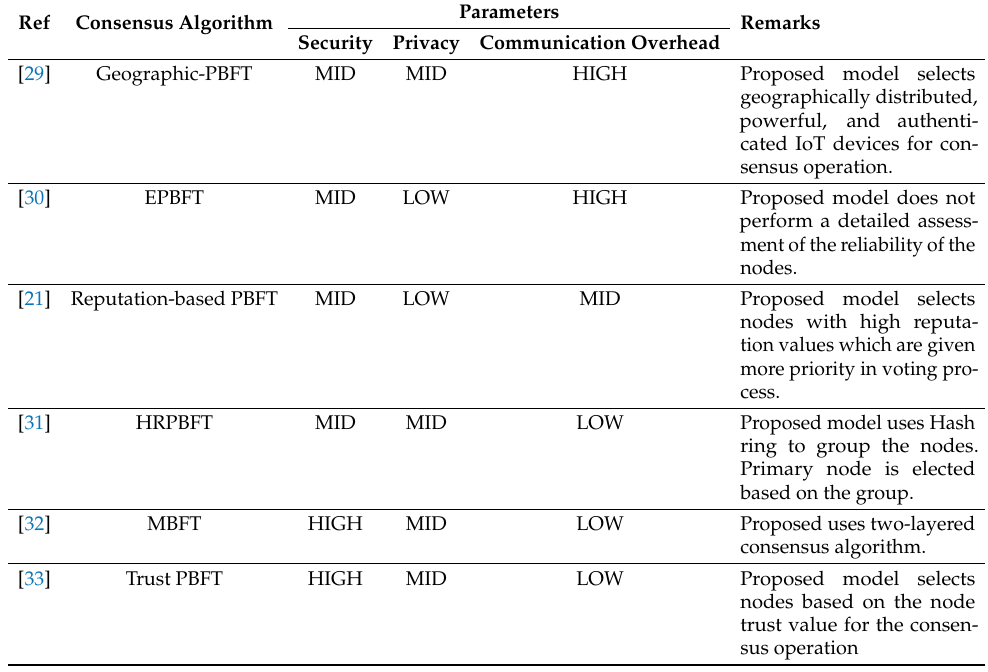
Table 2. Summary of existing PBFT consensus